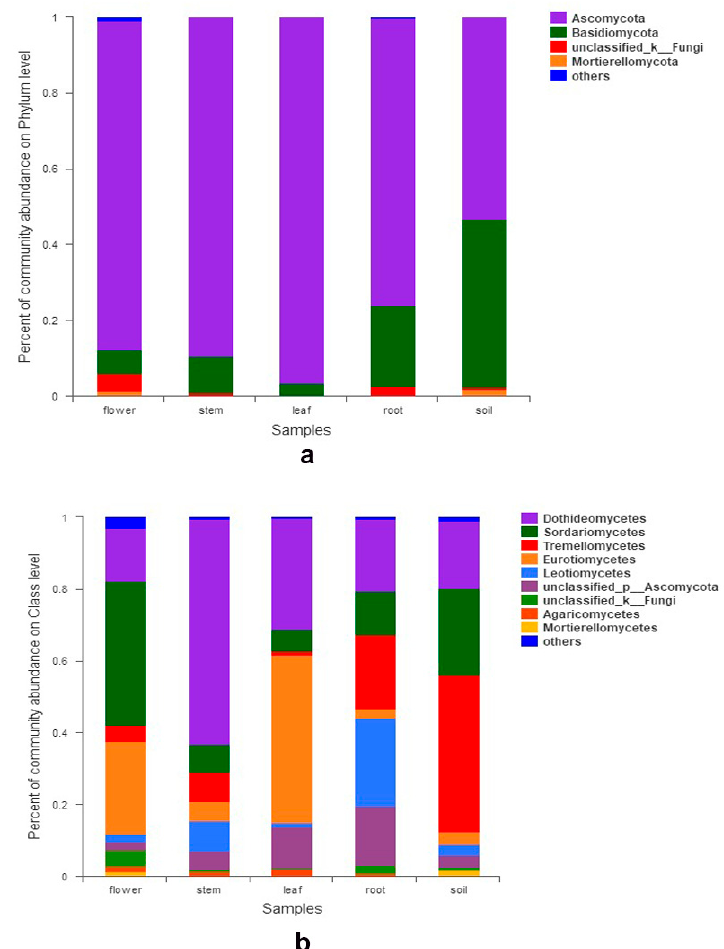
Figure 1. Fungal abundance in di ff erent organs and soil: ( a ) at phylum level; ( b ) at class level.